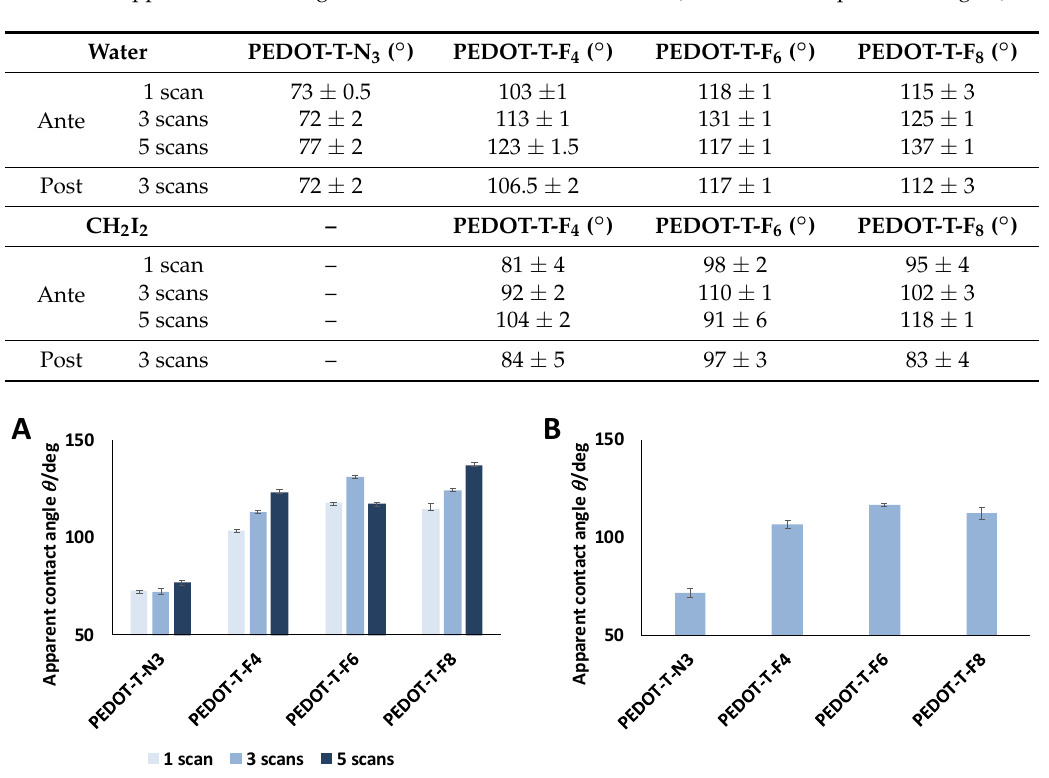
Table 2. Apparent contact angles with water and diiodomethane (all values are reported in degree).